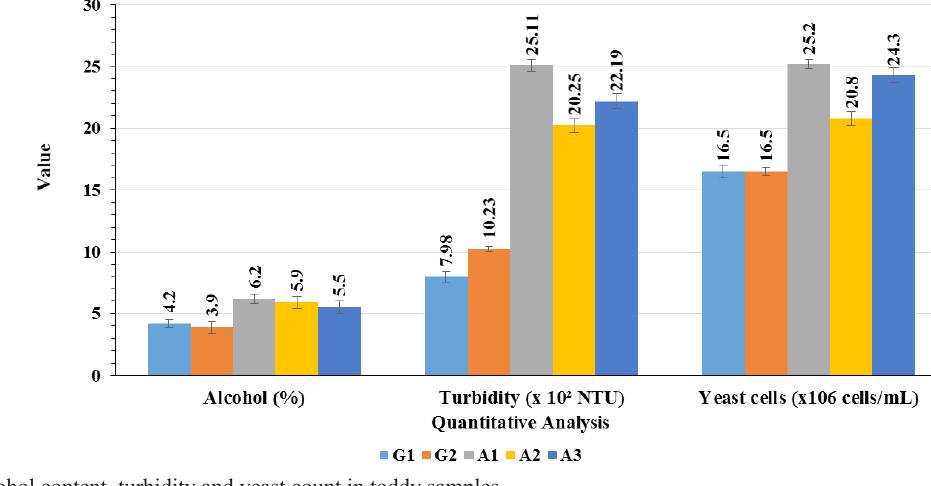
Figure 2: Alcohol content, turbidity and yeast count in toddy samples.